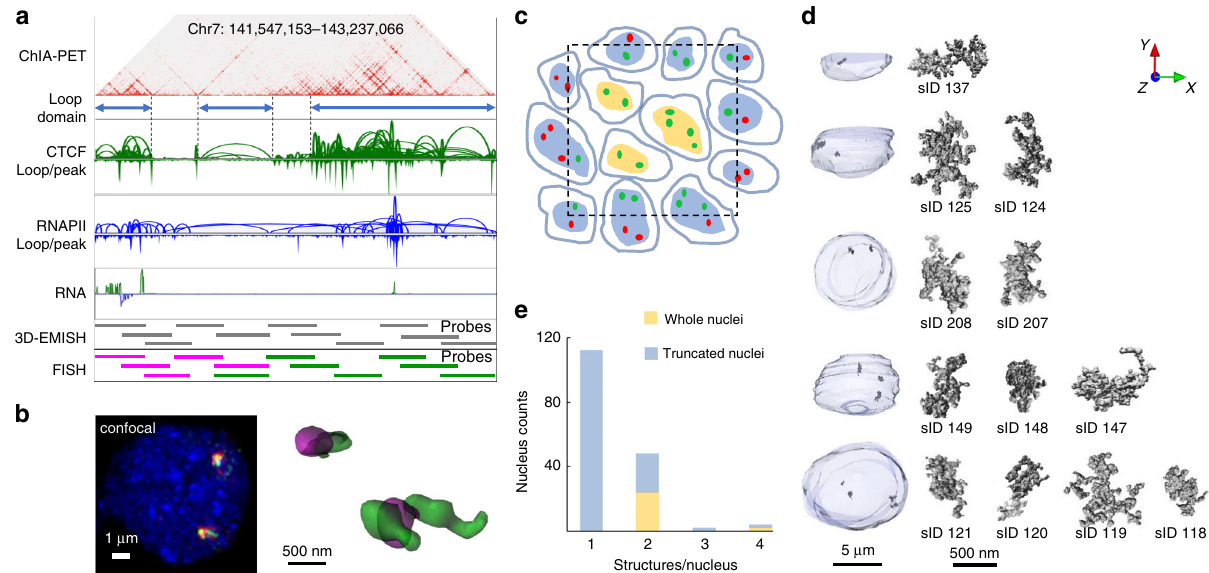
Fig. 2 3D-EMISH chromatin image collection for 1.7 Mb target genomic region. a Genome browser view of the target region in hg38,